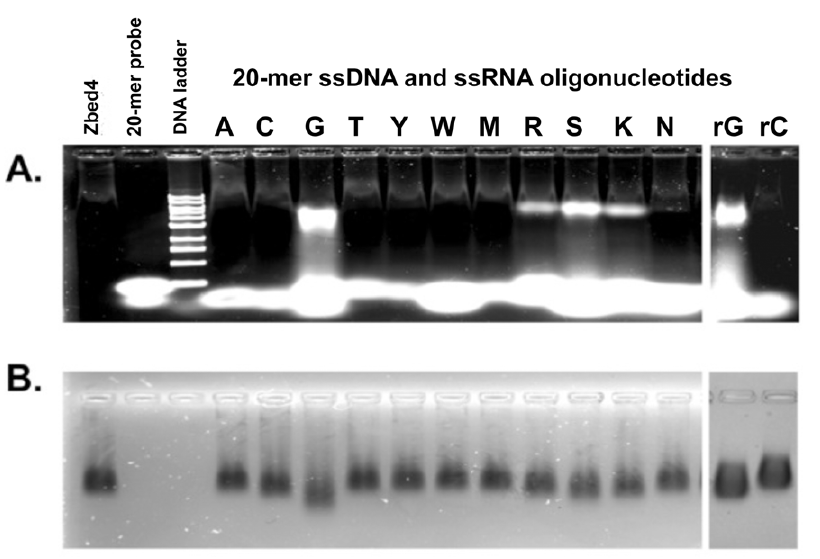
Figure 5. Relative affinity of recombinant Zbed4 for the different oligonucleotides. Zbed4 (20 m g) was incubated with 0.5 nM different 20- mer ssDNA (left panel) and ssRNA oligonucleotides (right panel) for 45 min and the whole reaction mixtures (20 m l) with the protein-DNA complexes were subjected to EMSA on 1% agarose gels run at room temperature in HEPES buffer, pH 8.2, at 20 mA. A . Agarose gel stained using SYBR Gold for detection of nucleic acid retardation. B. The same gel stained with Coomassie R-250 for detection of Zbed4 protein. Zbed4 (20 m g) and a single primer (0.5 nM) were applied separately to the gel as controls. 1 kb DNA ladder was used as a standard for nucleic acid size. As seen, Zbed4 binds only to DNA and RNA 20-mers that contain